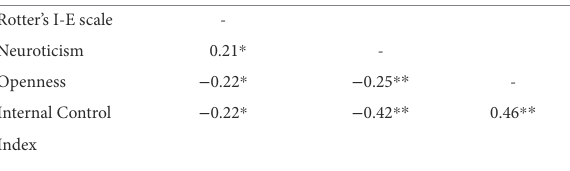
TABLE 6 Concurrent validity of Bangla Rotter’s I-E scale ( N = 178).